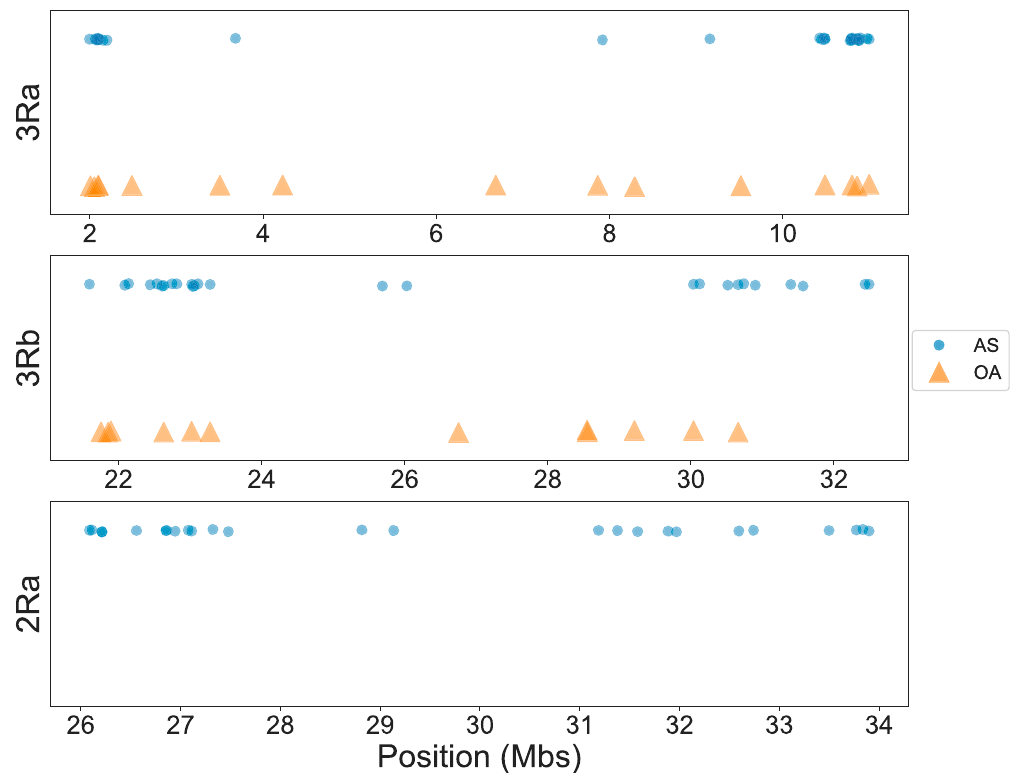
Figure 1. Locations of tag single nucleotide polymorphisms (SNPs) within each inversion for OpenArray (OA, orange triangles) and amplicon sequencing (AS, blue